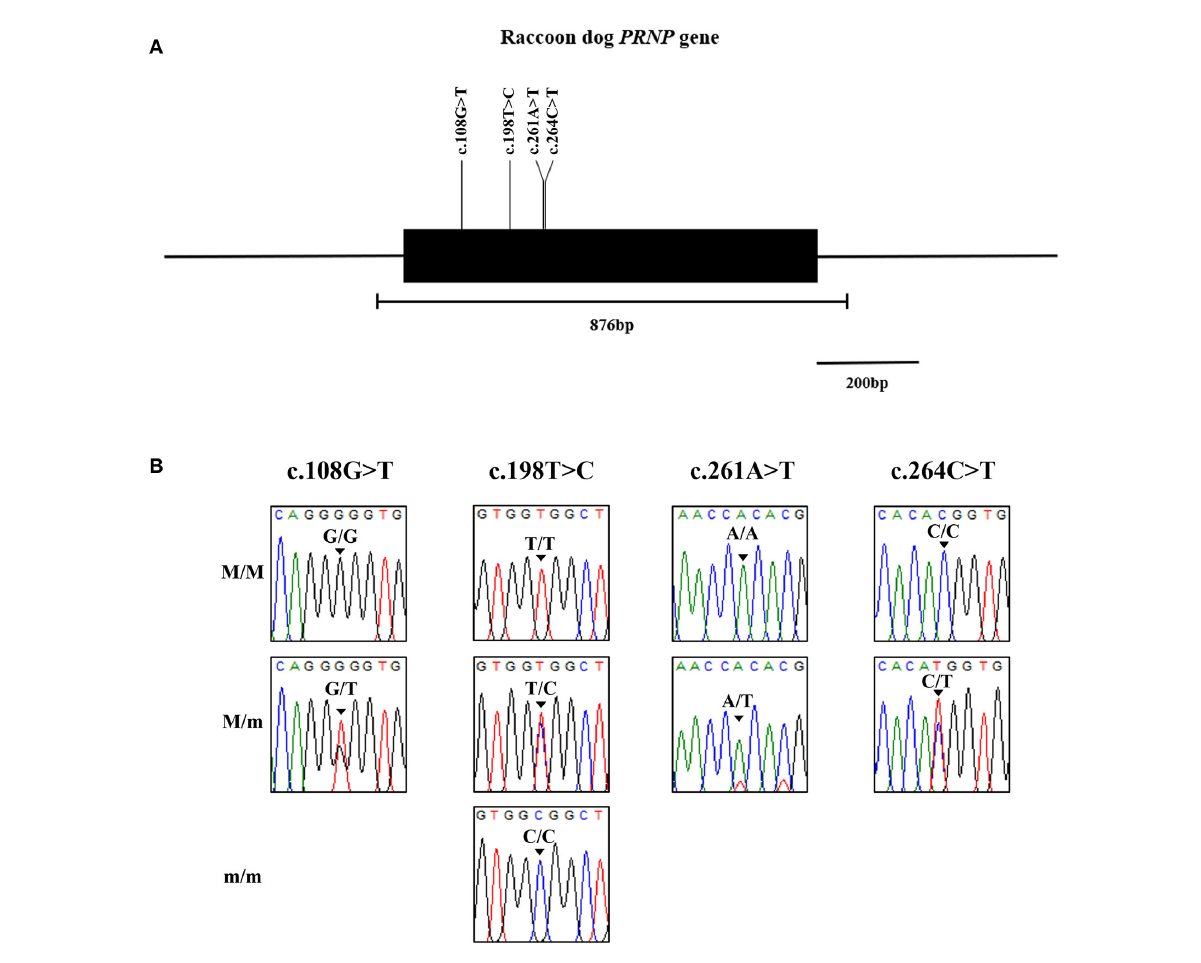
FIGURE1 Identification of novel genetic polymorphisms of the prion protein gene ( PRNP ) in 87 raccoon dogs. (A) Simplified gene map of the raccoon dog PRNP gene. The open reading frame (ORF) is indicated by a shaded block (774 bp). The edged horizontal bar indicates the regions sequenced (876 bp). Vertical lines indicate the novel genetic polymorphisms identified in this study. (B) Electropherograms of 4 novel single nucleotide polymorphisms (SNPs) of the PRNP gene found in raccoon dogs. The colors of the peaks indicate each base of nucleotides (green: adenine; red: thymine; blue: cytosine; black: guanine). M/M: major homozygote; M/m: heterozygote; m/m: minor homozygote.